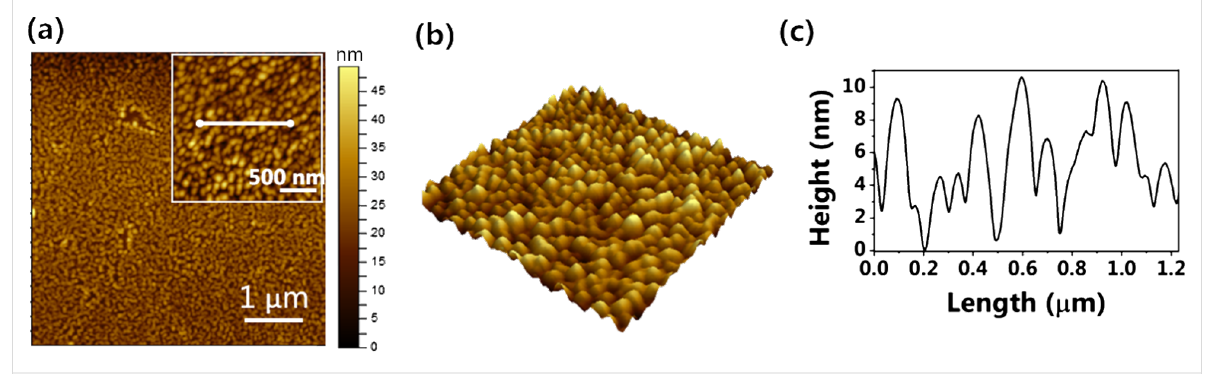
Figure 5: (a) AFM image of a 10 nm PbPc layer on single-layer graphene. The inset shows a magnified image of a 2 µm × 2 µm area. (b) 3D view of the inset image. (c) Profile section across the marked line in the inset of (a) showing the height variation.